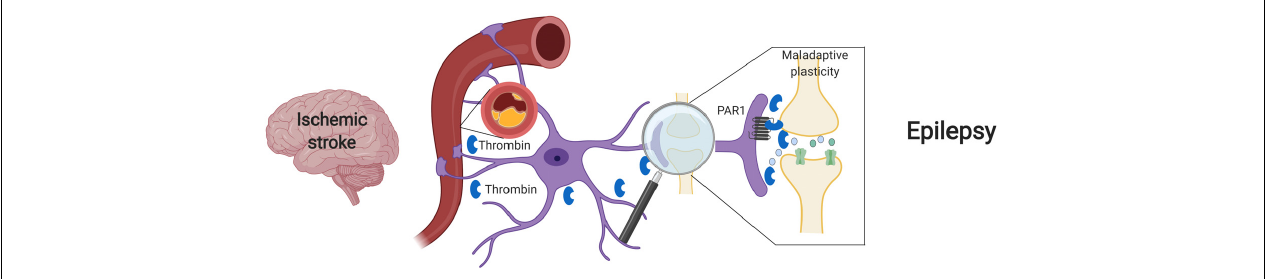
FIGURE 1 | Suggested model – Ischemic stroke leading to maladaptive plasticity and PSE: Following a cerebral vascular occlusion, thrombin increases in the brain. This increase may be as a result of BBB breakdown and entrance of vary blood components into the brain parenchyma or by brain tissue intrinsic production. Thrombin and its main receptor PAR1 enhance NMDA receptor activity and calcium entry, thus leading to a hyperexcitable state and to maladaptive plasticity. Eventually, synchronized epileptic activity occurs as a part of a PSE condition. Created with